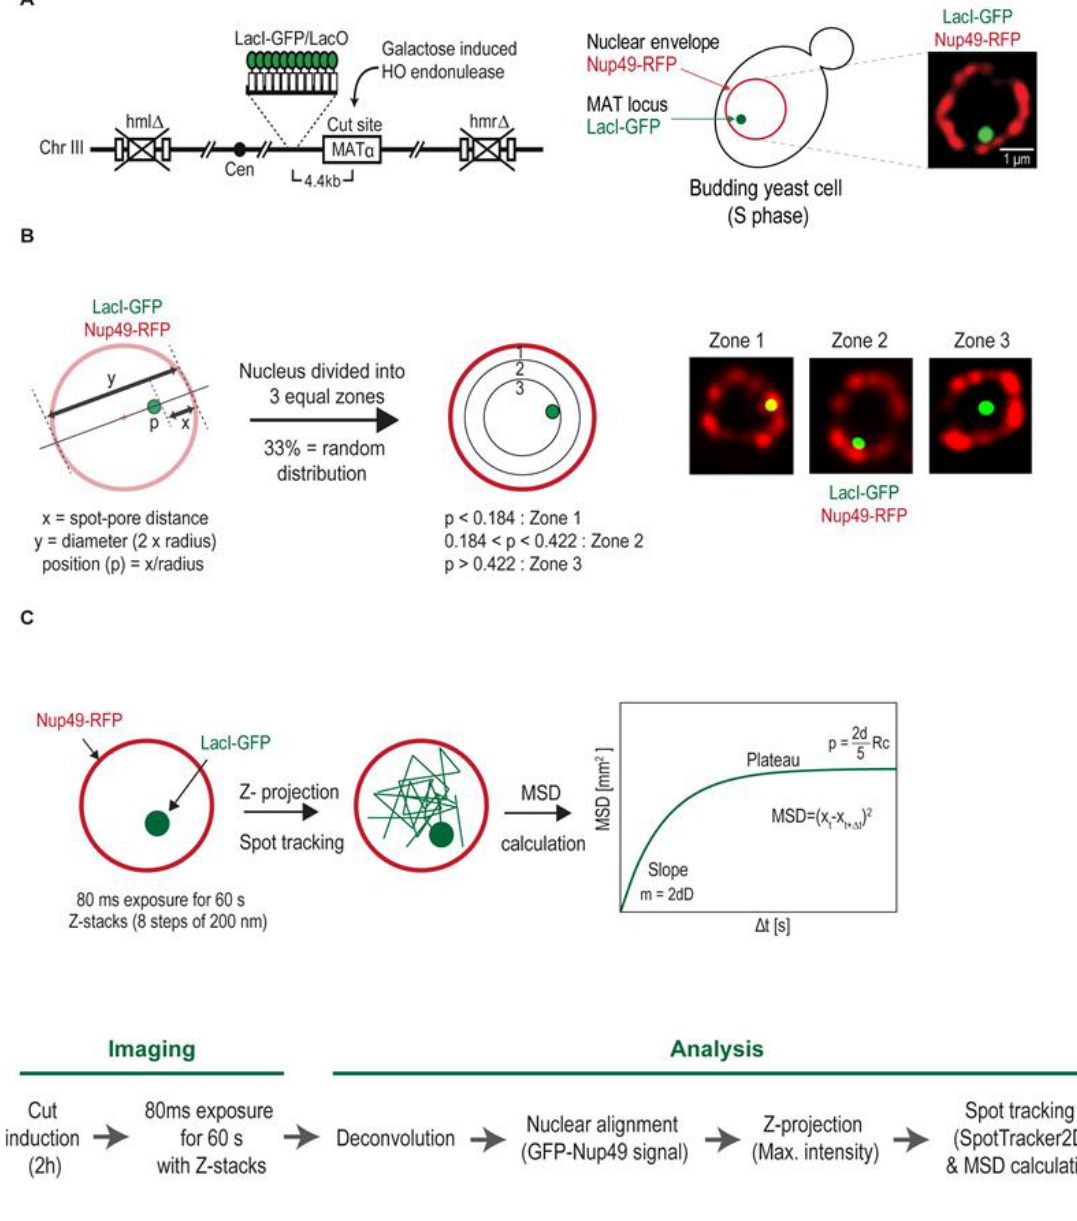
FIGURE 17: Visualizing chromosomal dynamics at a DNA DSB in the yeast S. cerevisiae . (A) Schematic representation of the chromosomal locus tagging system. HO endonuclease is used to generate a single DSB at the mating type locus ( MAT locus) that is tagged with a lacO array. The LacO array binds the LacI repressor fused to a green fluorescent protein (LacI-GFP). The nuclear envelope is visualized using a fluorescently tagged nuclear pore protein (Nup49-RFP). (B) Analyzing chromosomal locus position. Relative locus position (p) is calculated by normalizing the distance pore-locus (x) by the nuclear radius (y/2). The radial distances are then classified into three groups - Zone 1 (peripheral width=0.184 x nuclear radius( r )), 2 (middle width between 0.185 r and 0.422 r ) and 3 (central width=0.578 r ) - of equal surface. (C) Analyzing chromosomal locus mobility. Overview of the imaging procedure. Single cell, multi-stack images are acquired every 80 ms for 60 s. After deconvolution and nuclear alignment, the 3D images are converted to 2D using a maximum z-projection. The tagged locus is tracked using SpotTracker2D and an absolute MSD calculation is